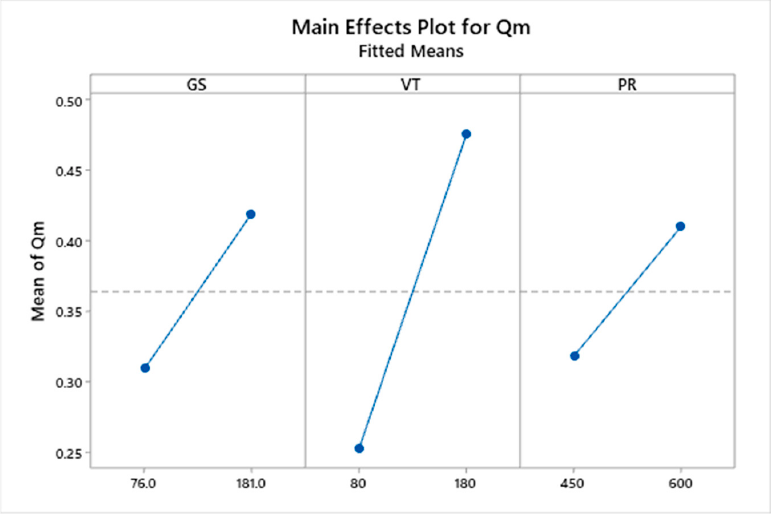
Figure 6. Main effects plot for material removal rate